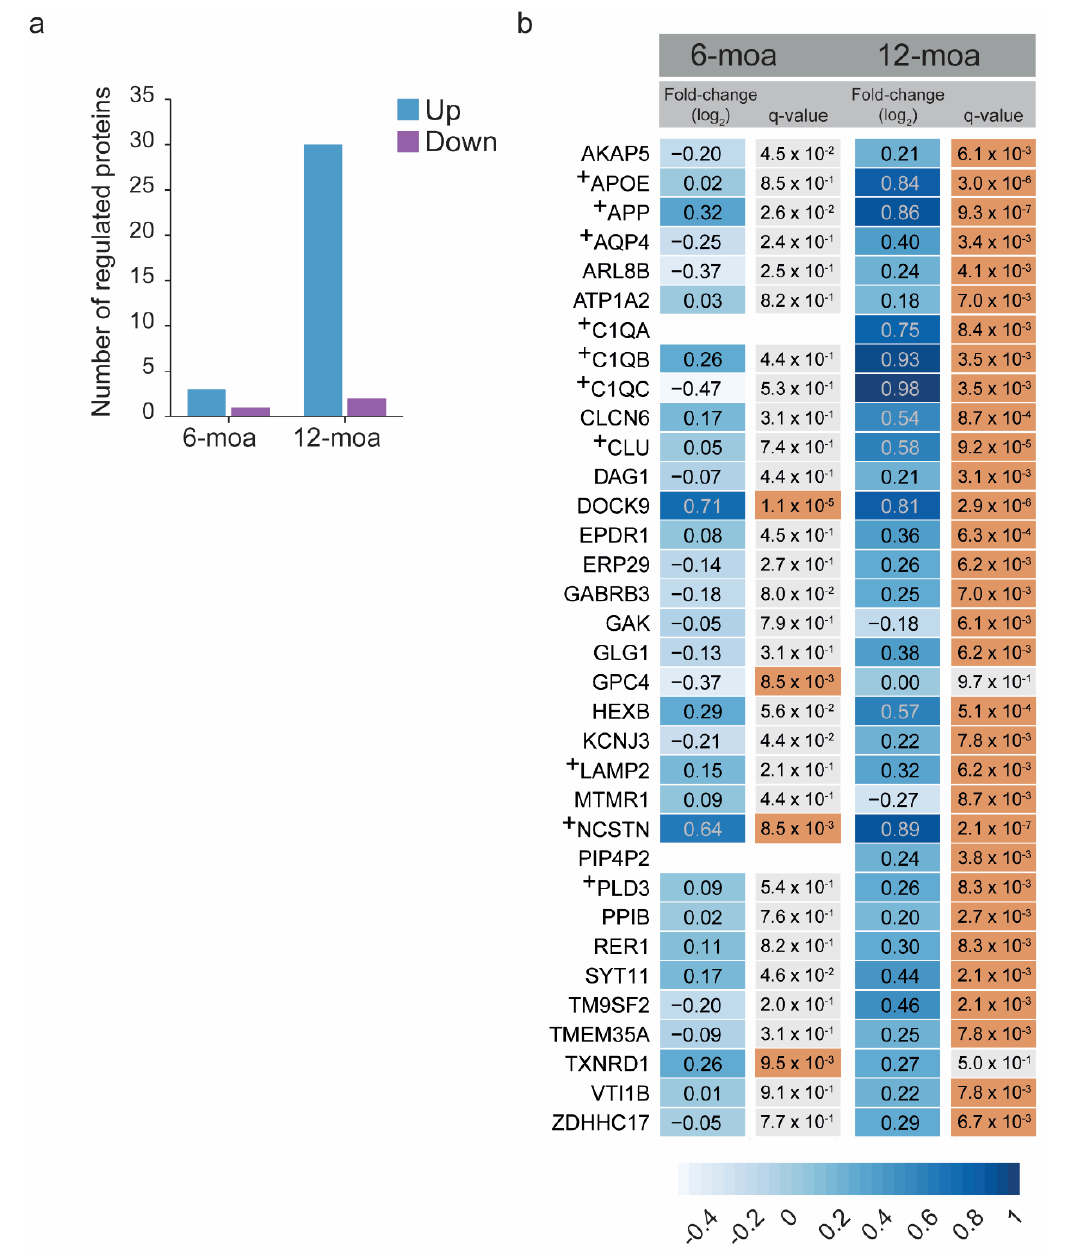
Figure 3. Differential expression analysis of 6- and 12-moa APP/PS1 mice. ( a ) Number of significantly higher and lower expressed proteins (empirical Bayes q -value ≤ 0.01) observed at 6- and 12-moa. ( b ) Fold-changes (log 2 ) and q -values of regulated proteins in at least one of the two datasets. Fold changes are emphasized in color from most extreme decrease (light blue) to highest increase (dark blue). q -values ≤ 0.01 are highlighted in orange. Proteins labeled with a+ have been implicated in human AD in previous reports, see Table S1.